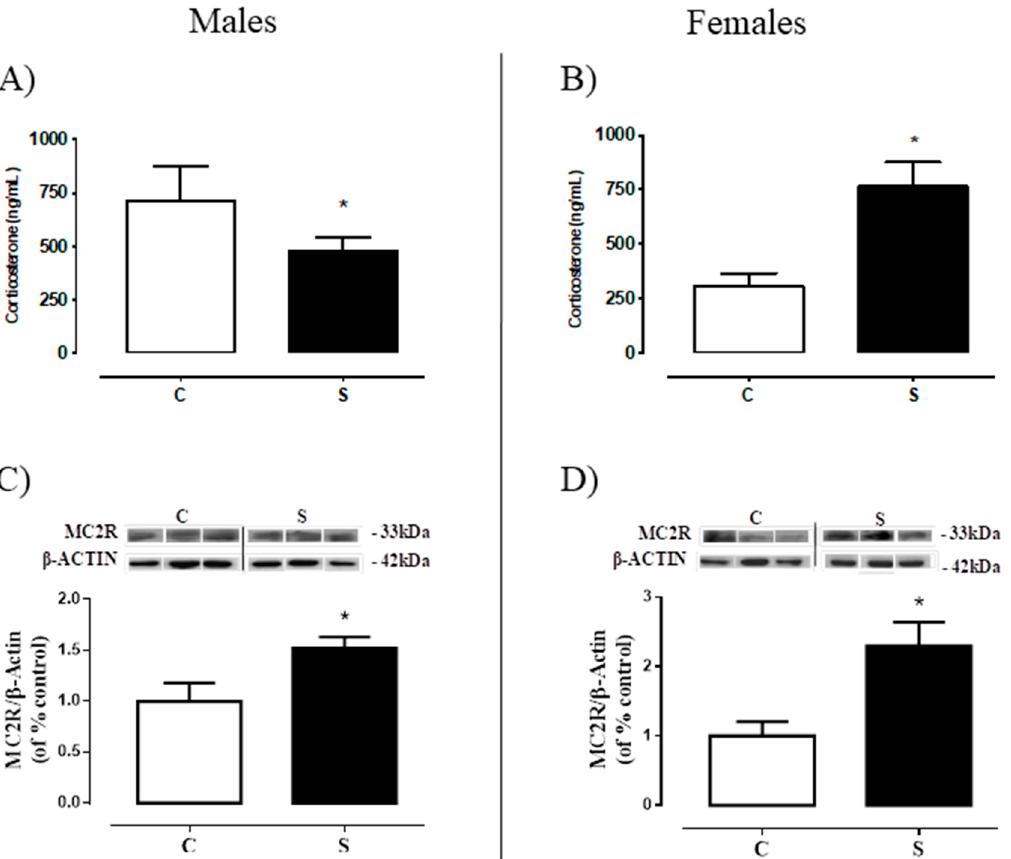
Figure 3. Corticosterone and ACTH receptor content in adult rats programmed by smoke exposure during the lactation period. Corticosterone levels in the plasma ( A —male; B —female) and melanocortin 2 receptor (MC2R) content in the adrenal gland ( C —male; D —female). Groups: C—CONTROL and S—SMOKE. alues are given as means ± S.E.M. of 8–10 rats/group. * p < 0.05 significant difference between S vs. C.